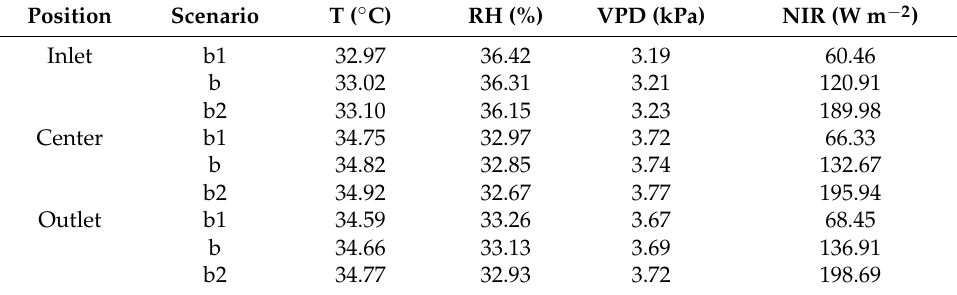
Table 7. Climate variation with a change in NIR intensity for scenario